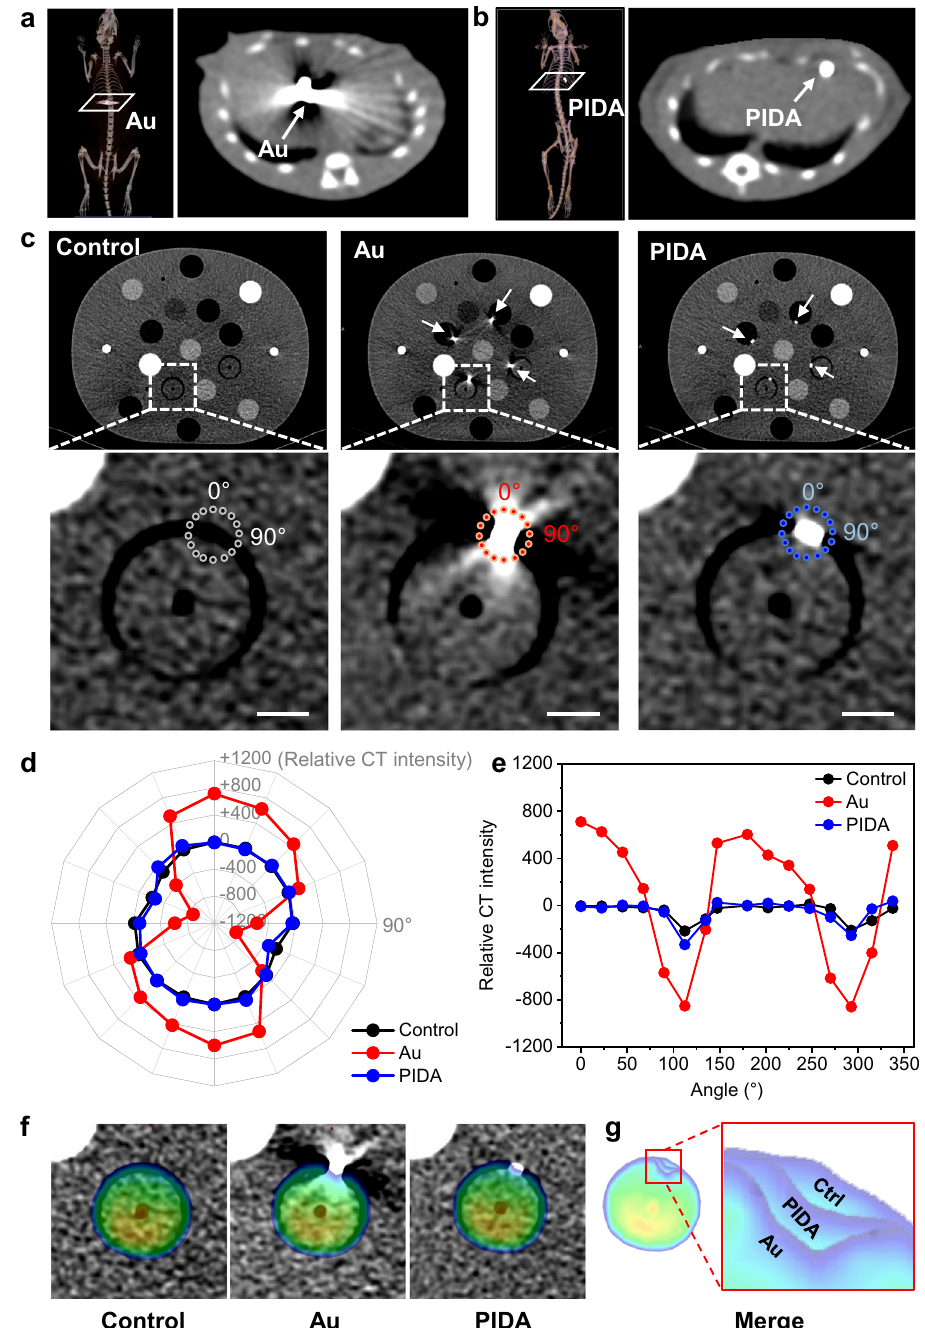
Fig. 5 Accurate radiotherapy dose distribution planning based on PIDA fi ducial marker. a CT images of the rat implanted with an Au fi ducial marker. b CT images of the rat implanted with a PIDA fi ducial marker. c CT images of thorax phantoms with movable plugs. Scale bar: 1 cm. Control: Thorax phantom with no marker inserted; Au: Thorax phantom with 4 Au markers inserted (pointed by white arrows); PIDA: Thorax phantom with 4 PIDA markers inserted (pointed by white arrows). d , e Quanti fi ed relative CT intensities of circled spot arrays in ( c ). f Radiation dose distribution for RRT planning calculated on basis of the CT values of the corresponding thorax phantoms in c . Source data are provided as a Source Data fi le. g Overlapping of the calculated radiation dose distribution of Control (Ctrl), Au, and